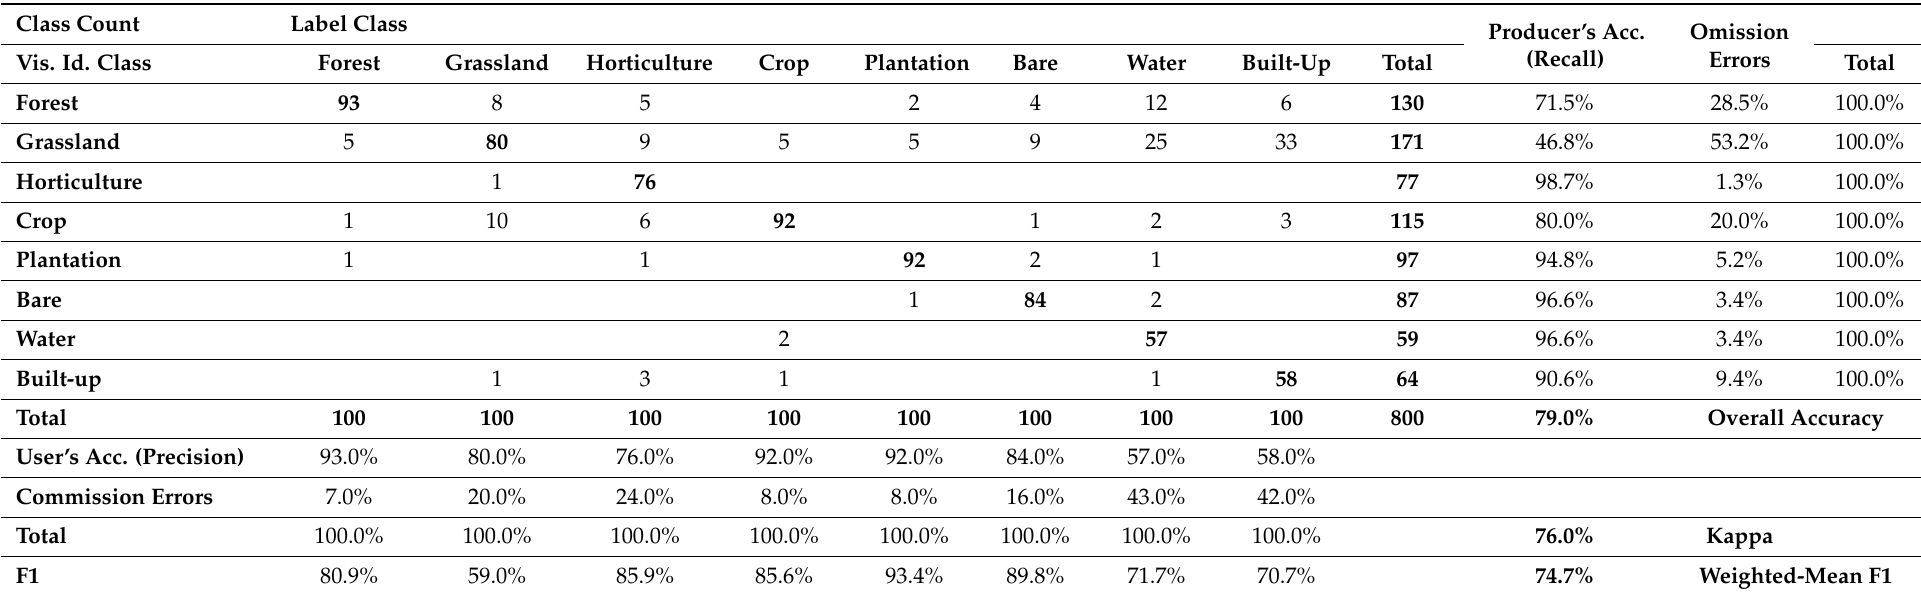
Table 2. Confusion matrix comparing visually identified class (rows) to label data class (columns). Rows indicate ‘true’ visually identified classes and columns indicate classes according to mapping. Matching class counts (diagonal), totals and primary metrics are in